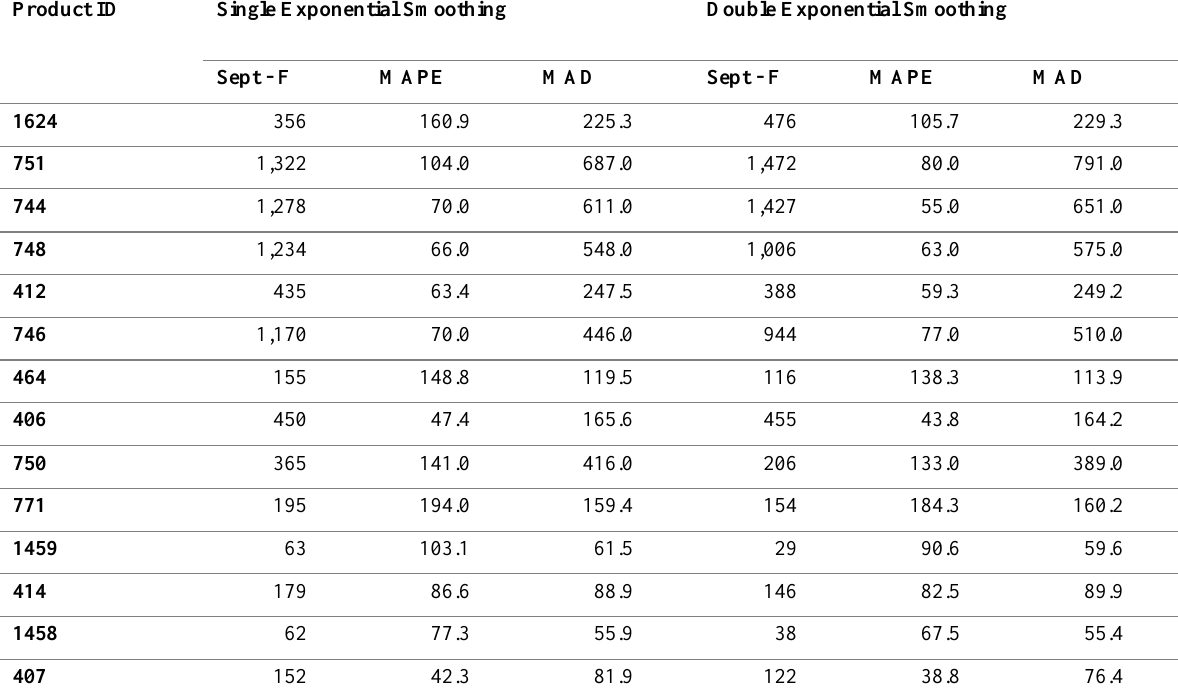
Table 1: September Demand Forecasting Result – Single and Double Exponential